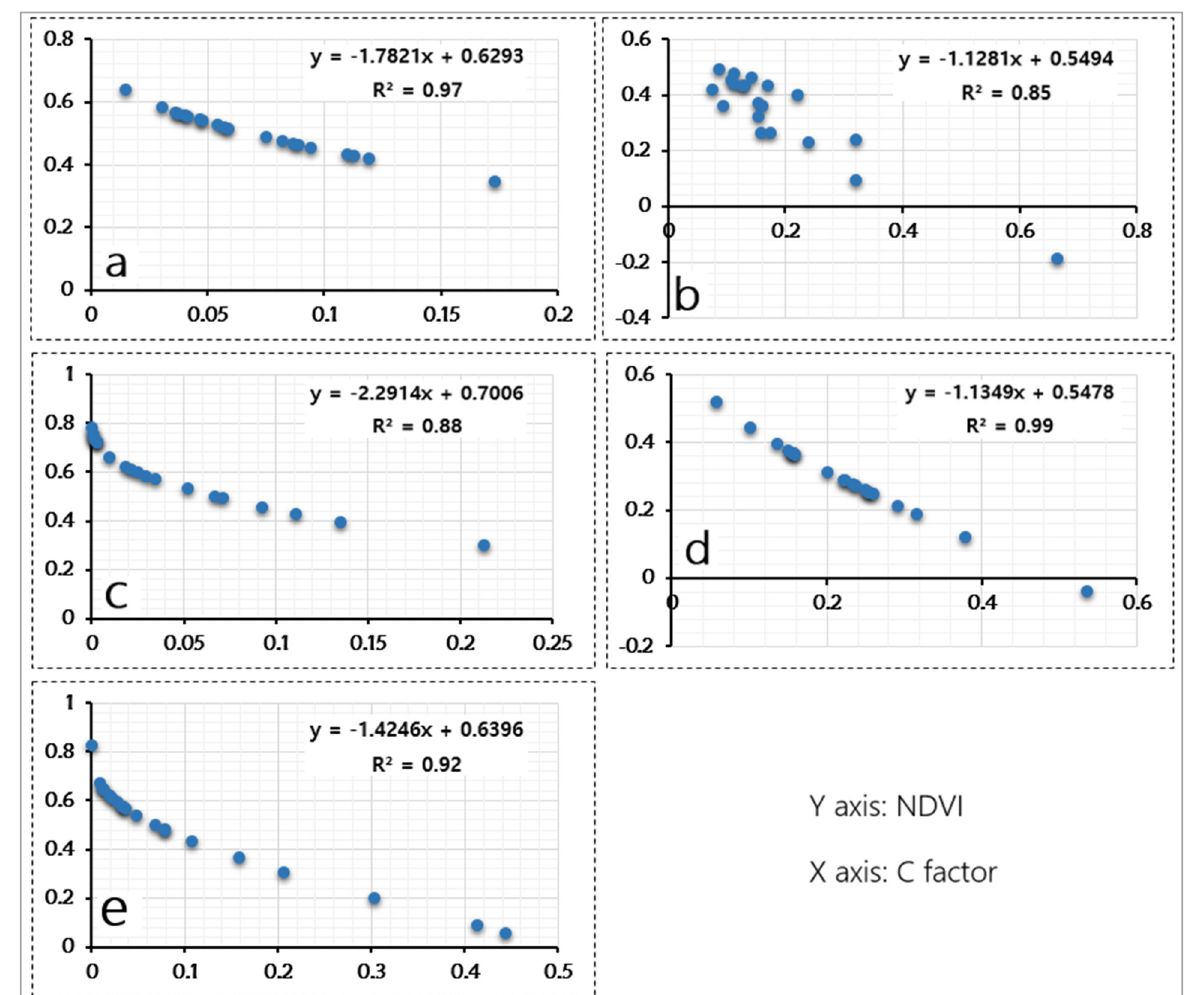
Figure 5. Correlation between NDVI and C-factor (C vk A) for each year: ( a ) 2000, ( b ) 2005, ( c ) 2010, ( d ) 2015 and ( e ) 2018.